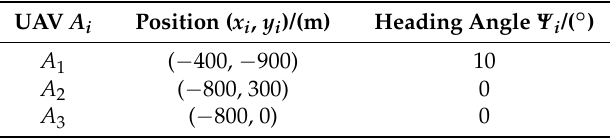
Table 6. The initial settings of three UAVs in Scenario